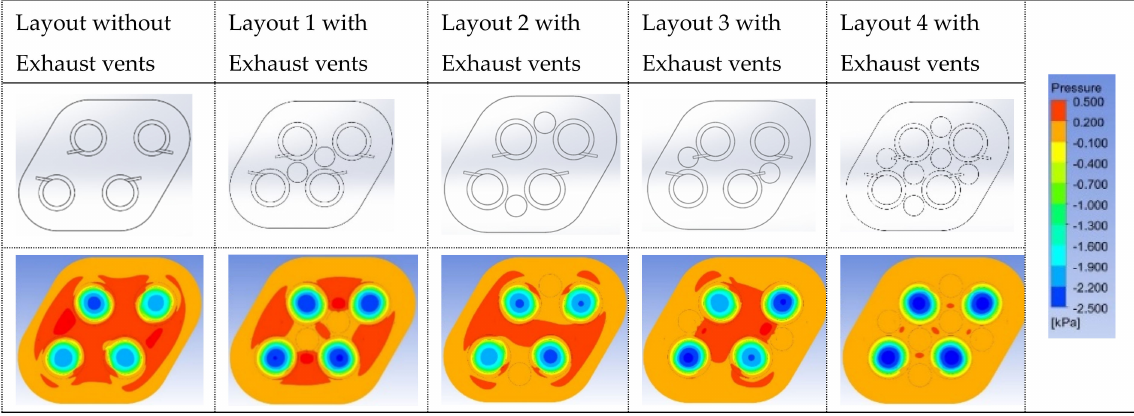
Figure 15. Pressure distribution of quad-vortex grippers with exhaust vents (configuration 2, L = 4/3 D 3 ).